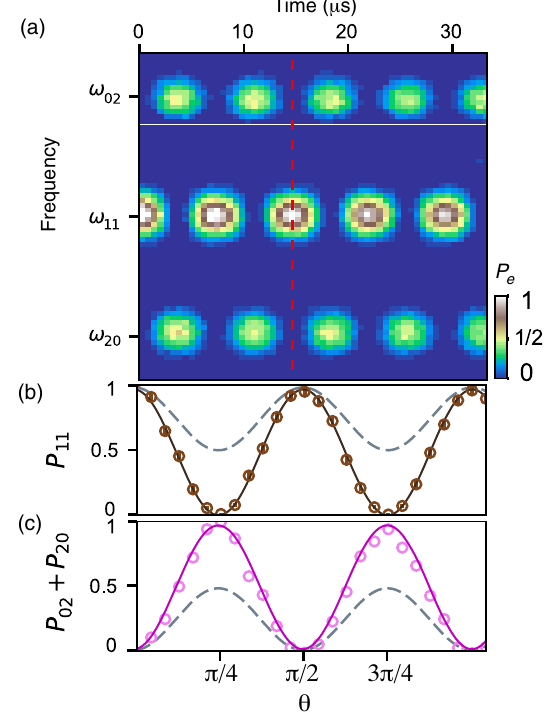
FIG. 3. HOM interference between Alice and Bob. (a) Data show the joint population as the initial state j 1 ; 1 i evolves AB ˆ U under θ . We observe out-of-phase oscillations between P 11 and an equal superposition of j 0 ; 2 i and j 2 ; 0 i . (b),(c) 1D cuts to AB AB show the behavior of P 11 (brown) and P 02 þ P 20 (magenta) up to ∼ 15 μ s (red dashed line). A simulation of two indistinguishable photons is shown in solid lines and that of two distinguishable photons is shown in dashed gray